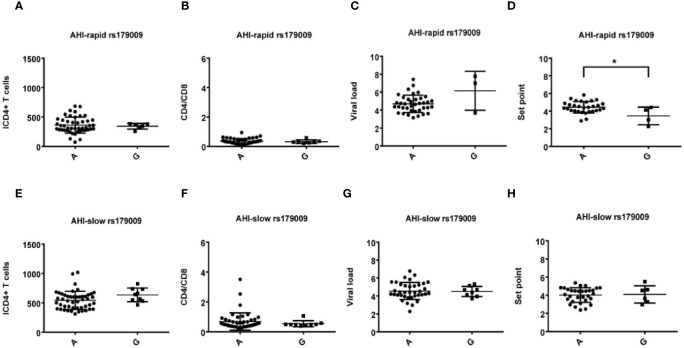
Relationship between rs179009A/G and clinical parameters in AHI patients with rapid/slow progress. (A–H) There are four clinical parameters including, ICD4 (initial CD4 T cells) (A, E), CD4/CD8 (the ratio of CD4 versus CD8 T cells) (B, F), viral load (C, G) and set point (D, H). The y axis indicates the values of these four respective parameters. The x axis, indicates two patient groups with TLR7 rs179009A/G allele. The text on the top of each picture represents AHI-rapid/slow patients. Each dot represents an MSM individual, (●) represents individuals of AHI-rapid/slow progress with TLR7 rs179009A allele. (■) represents individuals of AHI- rapid/slow progress with TLR7 rs179009G allele. * indicates P < 0.05; P < 0.01 and P < 0.001.